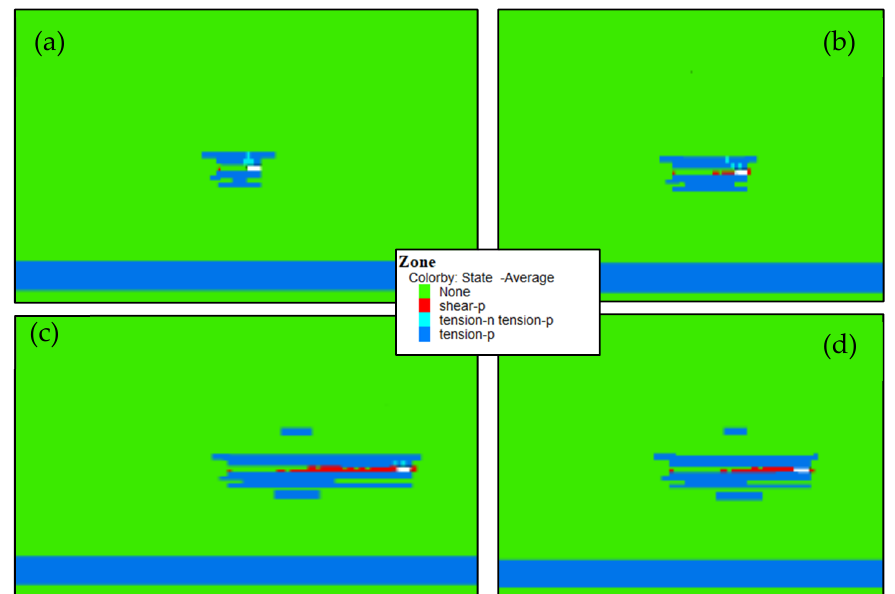
Figure 15. Plastic zone in the paste-filling working face under different filling steps of ( a ) 1 m, ( b ) 2 m, ( c ) 3 m, and ( d ) 4 m.